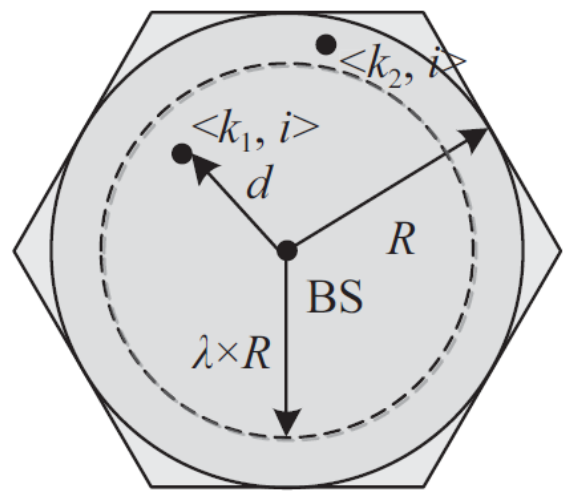
Figure 2. IPLUG policy decision parameters for user grouping.